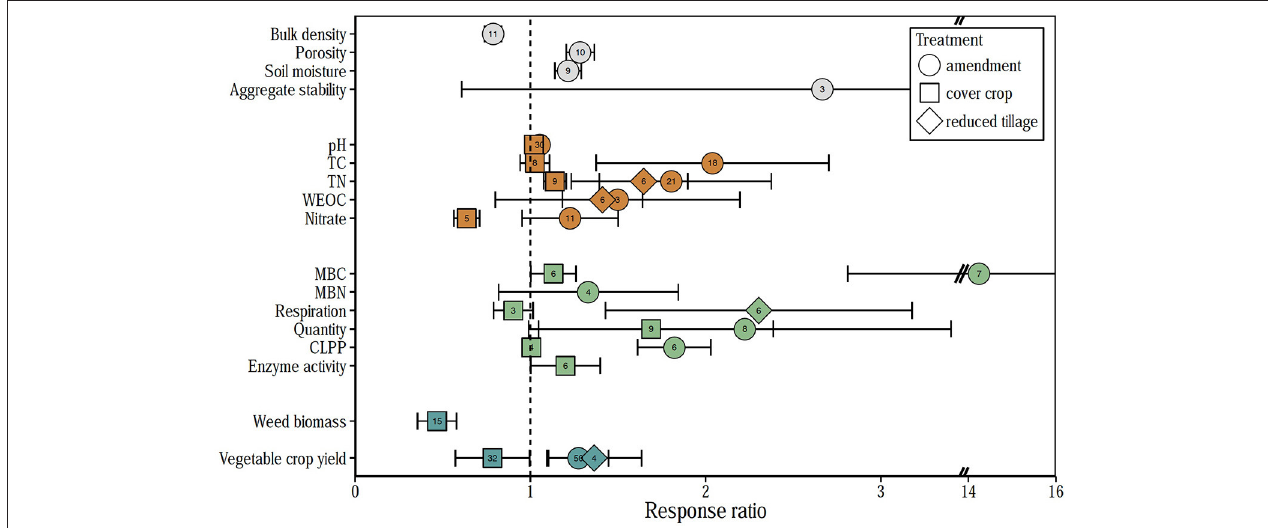
FIGURE 3 | Effects of alternative management practices on soil physical, chemical and biological properties as indicators of soil health separated by management treatment (organic amendment, cover crop, reduced tillage). All points are presented as Response Ratios (RR) with the 95% confidence interval and the respective number of comparisons (n) presented inside the circle. TC, total carbon; TN, total nitrogen; WEOC, water extractable organic carbon; MBC, microbial biomass carbon; MBN, microbial biomass nitrogen; CLPP, community level physiological profile.